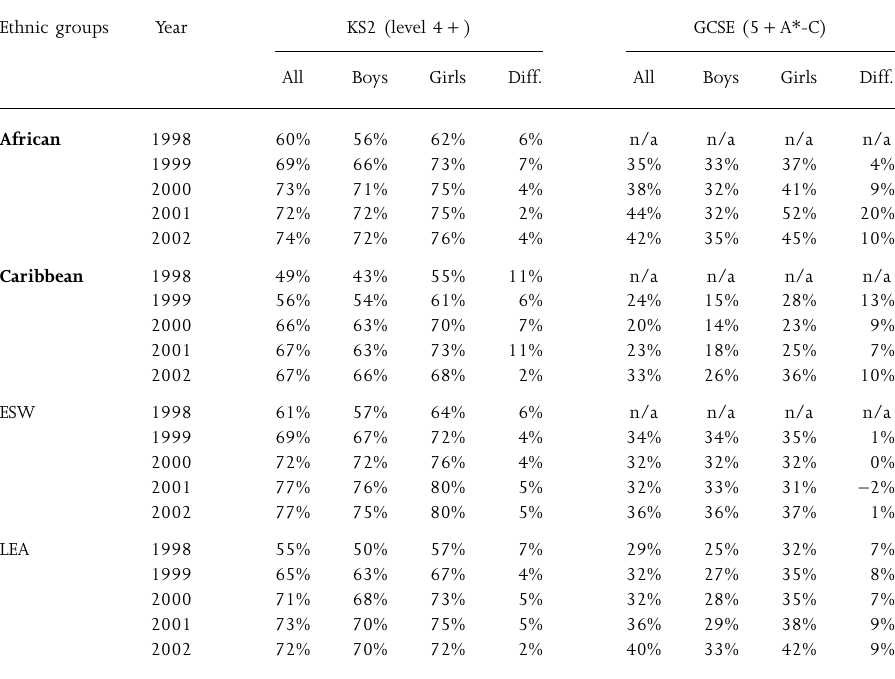
Table 2 Performance by key stage, gender and ethnic background (percentage) Ethnic